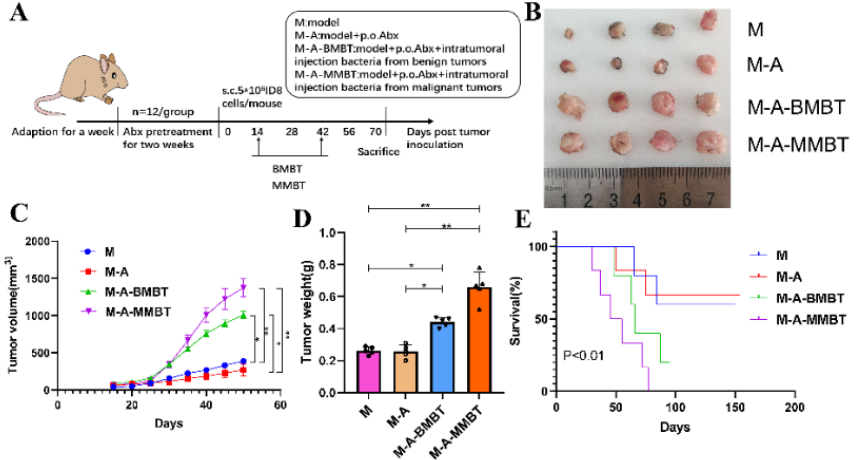
Figure 3. Injecting intratumourally with mixed bacteria from EOC significantly promoted tumour growth and reduced tumour model survival compared to mixed bacteria from EBOT. ( A ) Scheme of animal experiments. ( B ) Images of tumours in different treatment groups for 70 days. ( C ) Changes in tumour volume over time in different treatment groups. ( D ) Final tumour weights in different treatment groups. ( E ) Kaplan–Meier survival curves of mouse EOC models in different treatment groups. Data are presented as means ± SD. Two ‐ way repeated measures ANOVA, both with Tukey’s test for multiple comparisons, ( B – D ), respectively, and log ‐ rank test were performed for survival data ( E ); * p < 0.05, ** p <